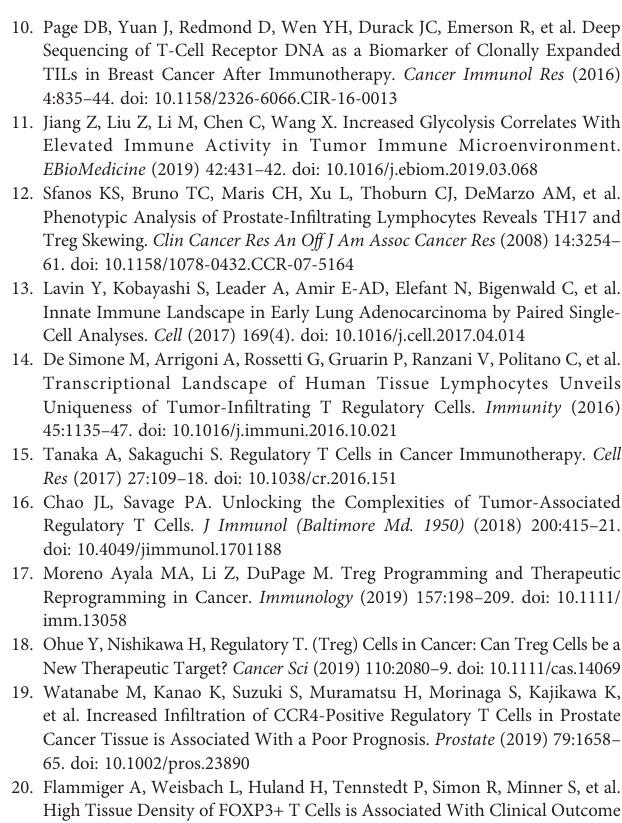
Supplementary Figure 1 | (A) CD4+CD25+CD127- Tregs and (B) CD4+CD25- T cells (Teff) were enriched using fl ow cytometry. Antibodies speci fi c for CD4, CD25 and CD127 were used to distinguish viable target cells. Supplementary Figure 2 | The correlations of the TILTregSig with cancer stem scores in the RNA expression levels (A) and DNA methylation levels (B) . Supplementary Figure 3 | The TILTregSig is an independent prognostic factor for prostate cancer patients. Univariate (A) and multivariate (B) Cox regression of prognosis factor for RFS of prostate cancer patients. (C) Kaplan – Meier analysis of RFS for prostate cancer patients strati fi ed by stage T, N, age, race, treatment response, postoperative RX and laterality. Supplementary Figure 4 | The correlation between the TILTregSig and immune- related factors, including chemokines, immunoinhibitors, MHCs and